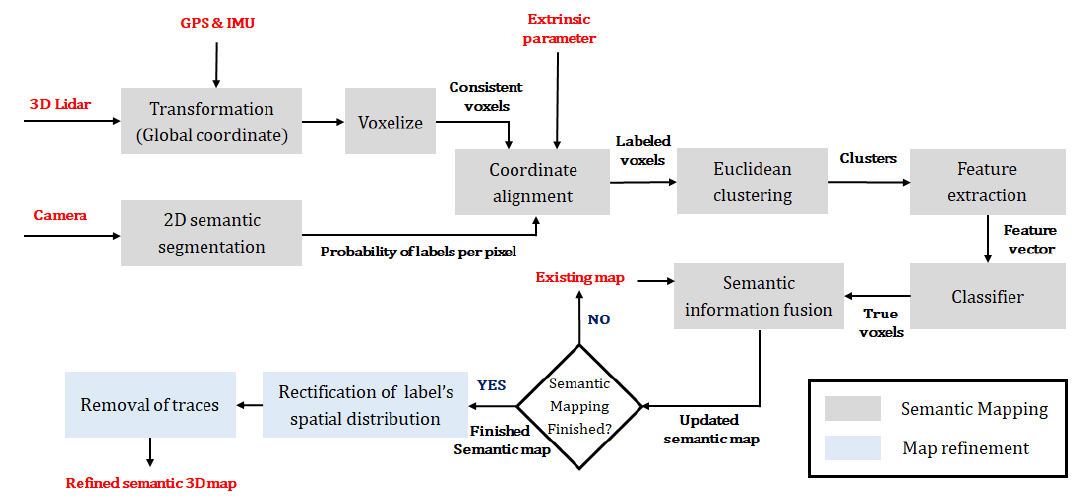
Figure 2. Flowchart of the semantic 3D mapping